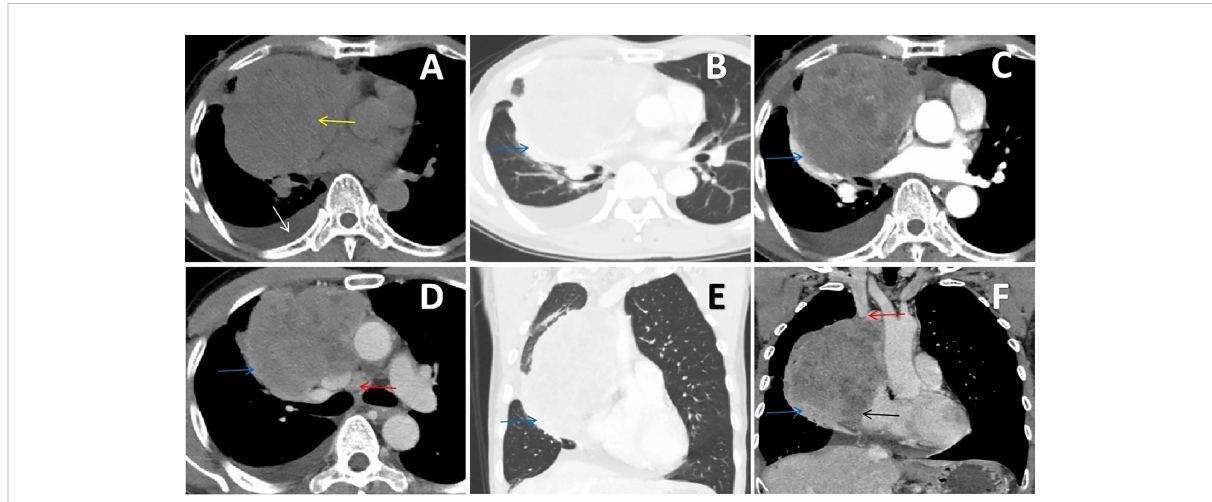
FIGURE 1 (A, B) Chest CT scan showing an irregular soft tissue density mass (yellow arrow) on the right side of the anterior mediastinum that compressed the adjacent right lung (blue arrow), accompanied by pleural effusion (white arrow). (C, D) Contrast-enhanced chest CT scan showing that the mass had moderately uneven enhancement, which invaded the right lung (blue arrow), and the mediastinal lymph nodes were enlarged (red arrow). (E, F) The coronal multiplanar reconstruction images clearly delineated the irregular and uneven density mass on the right side of the anterior mediastinum with invasion of the superior vena cava (red arrow), pericardium (black arrow) and right lung (blue